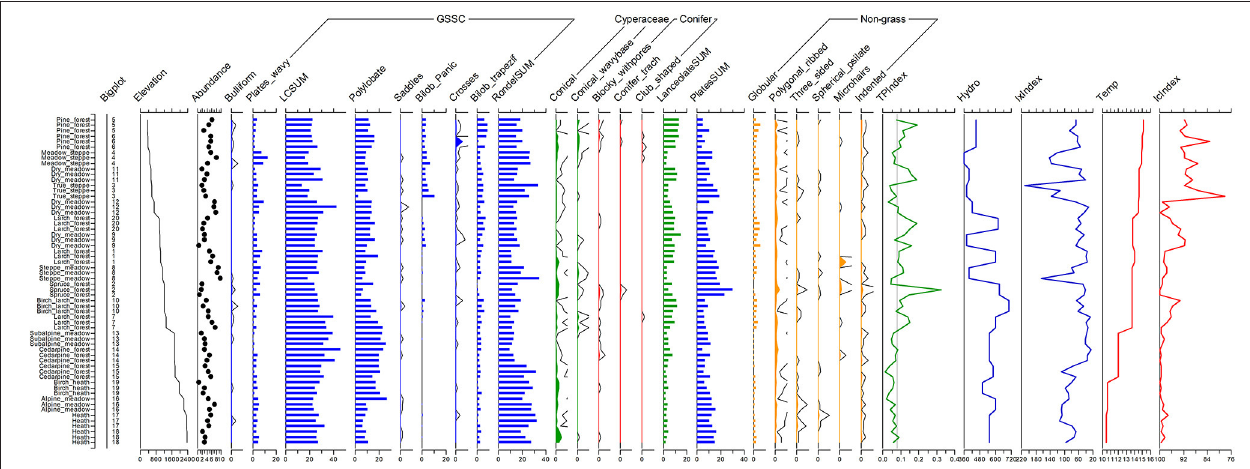
FIGURE 3 | Diagram of phytoliths at the aggregated level of classification (sums of rondels, long cells, lanceolates used). Bigplot numbers correspond to sampling locations in Figure 1 . Elevation is in m a.s.l. Abundance of phytoliths is expressed as % of phytolith extract relative to the original dry weight of each sample. All morphotype values are in % of the total sum of all counted phytoliths per sample (between 500 and 600 were counted). GSSC—phytoliths of grass silica short cells. LCSum is the sum of all long cells. TP, Ic, and Ix indices are based on phytolith data and are explained in text. Temp and hydro regime values are based on the scheme of Sedelnikov (1988) and are explained in text.